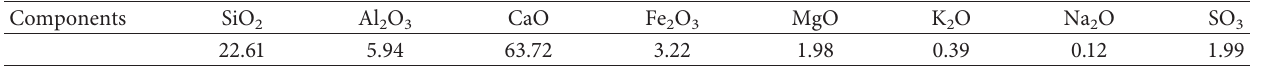
Table 1: Chemical analysis of the cement (wt%).